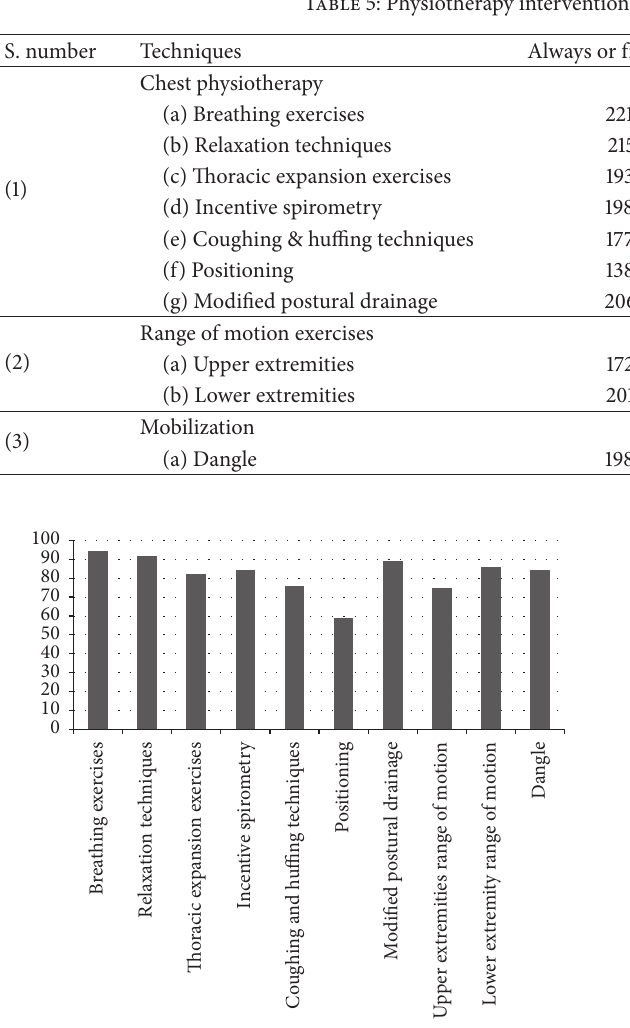
Figure 5: Physiotherapy interventions used on the 1st postoperative